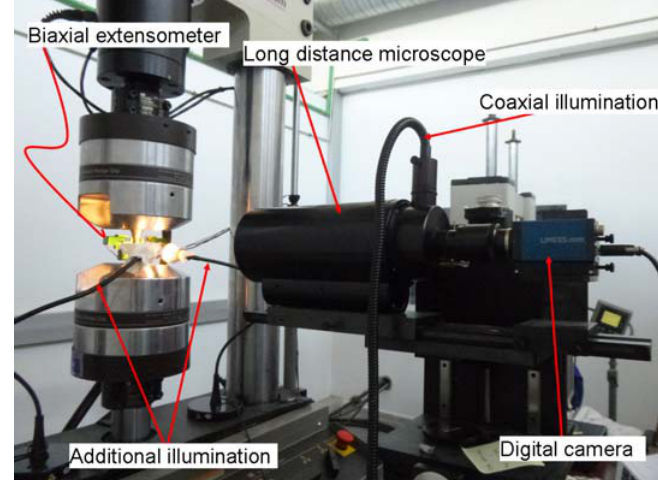
Figure 3: Experimental setup employed in this work.